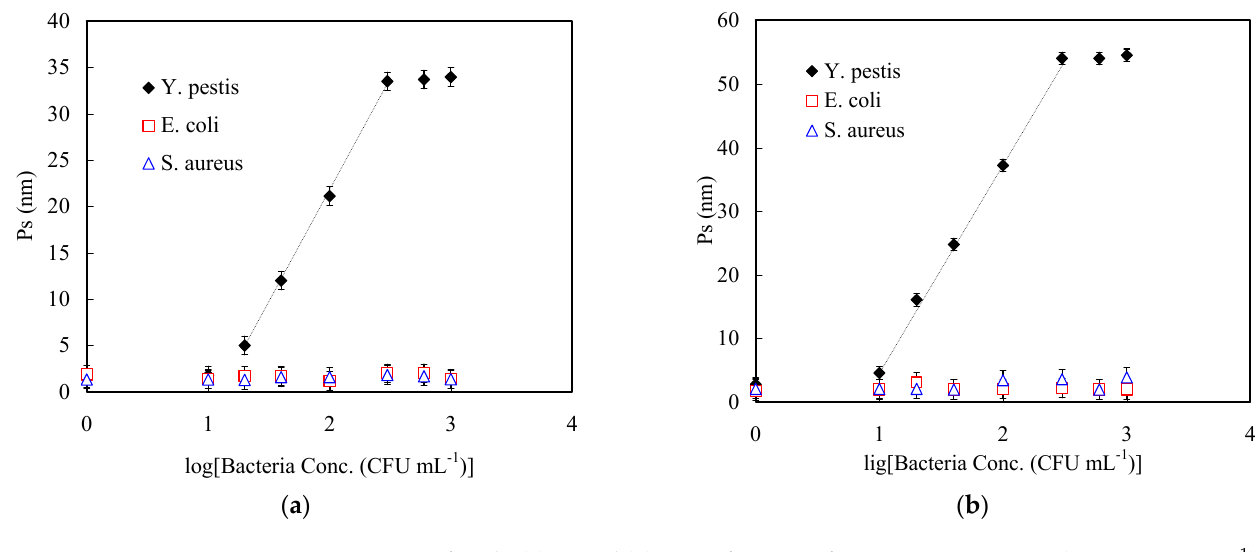
Figure 8. P s of peaks ( a ) IV and ( b ) V as a function of Y. pestis concentration (1–1000 CFU mL − 1 ). Table 2. Determination of agY in three blood samples after cell lysis by commercial ELISA and the as ‐ prepared SPHR sensor (Wilcoxon signed ‐ rank test: p > 0.05).